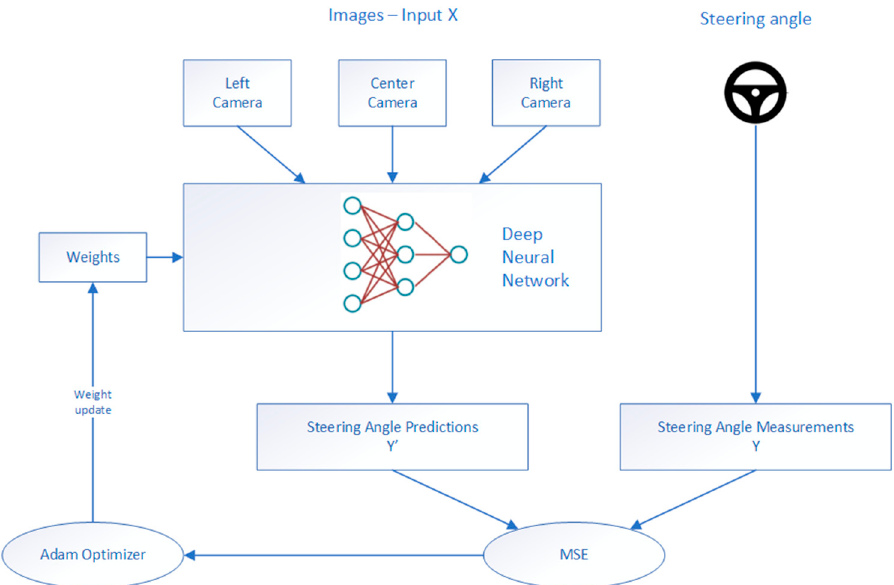
Figure 14. Training flowchart. Data collection is done in manual driving mode by acquiring images from three cameras mounted on the vehicle: central, left, and right in parallel with recording the steering angle paired with each image. During the training process, the correction factor has been added to the left and right images.